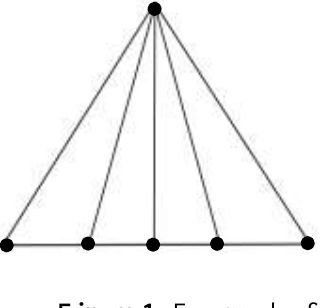
Figure 1: Fan graph of order 5.